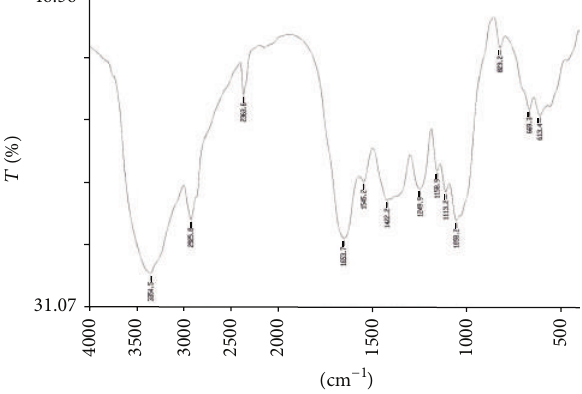
Figure 8: FTIR spectra of − NO 3 (AN) treated biomass showing different functional groups. The “ 𝑥 ” axis of the spectra denotes wavenumber (cm −1 ) and “ 𝑦 ” axis denotes transmittance (% 𝑇